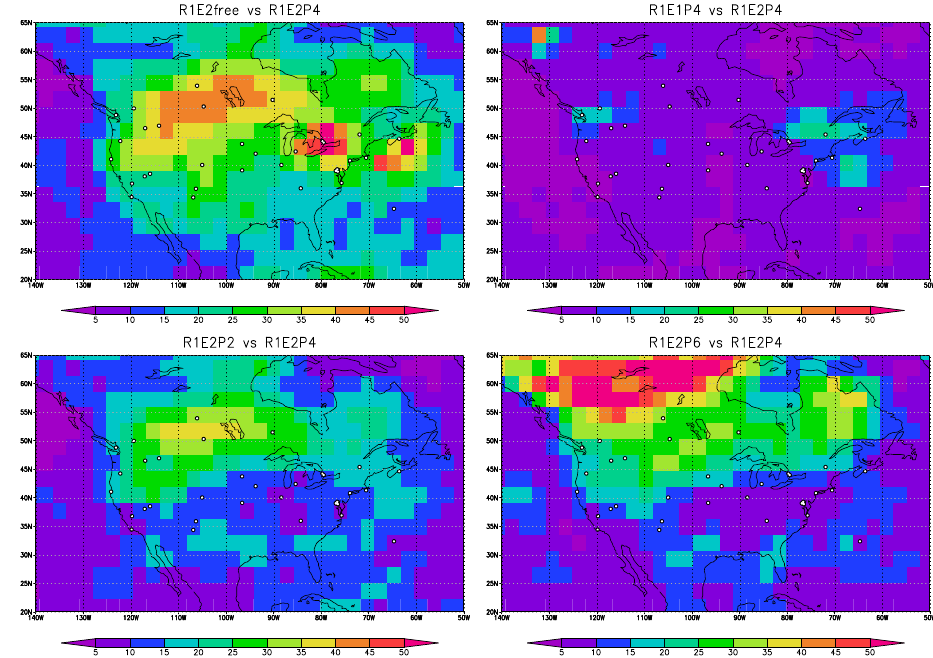
Fig. 5. Time-averaged differences [%] in AOT, for n reg = 1 experiments. The black & white dots represent AERONET sites.